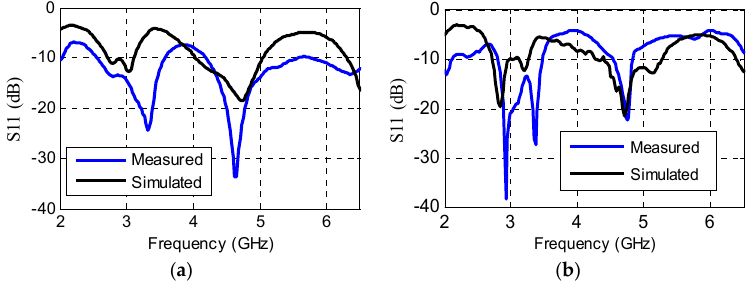
Figure 7. Simulated and measured results on Kodak photo paper ( a ) Return loss of antenna only; ( b ) Return loss of antenna with electrode on Kodak photo paper.